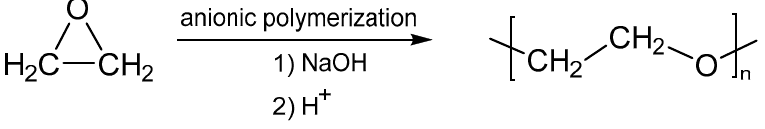
Figure 12. Synthesis of PEG.